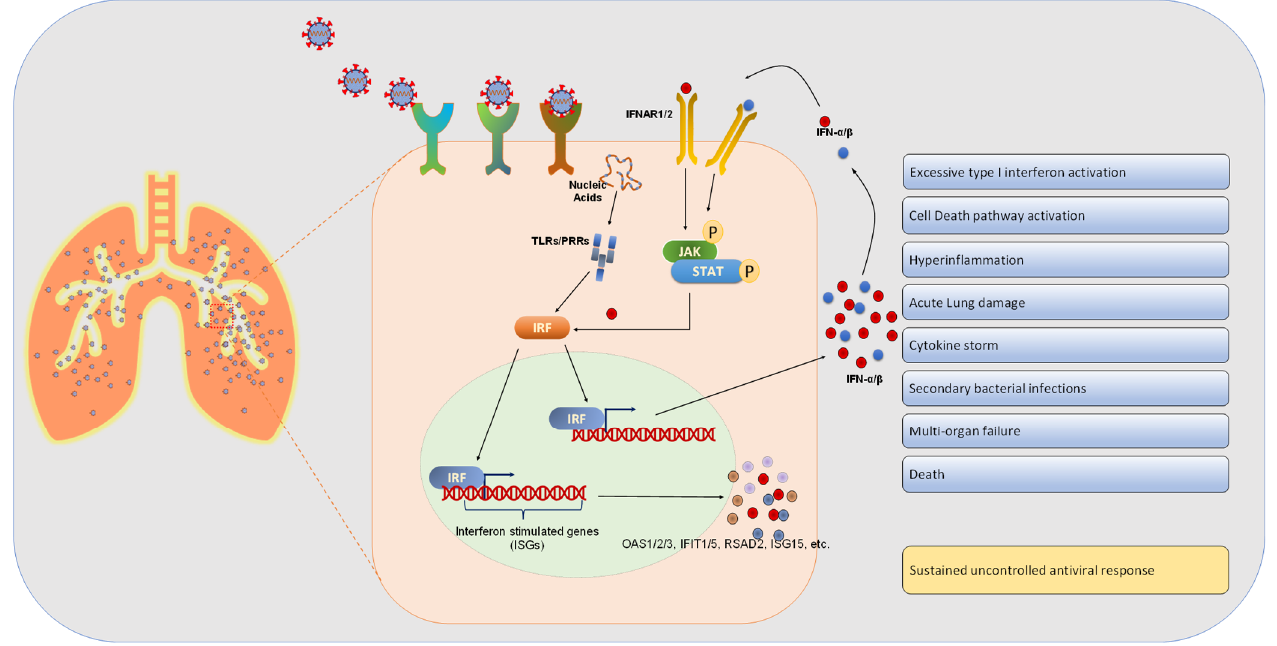
Figure 2. Schematic illustrating the effects of upregulated IFN-I response in hyperinflammation and severe COVID-19 patients supported by transcriptomic analysis.